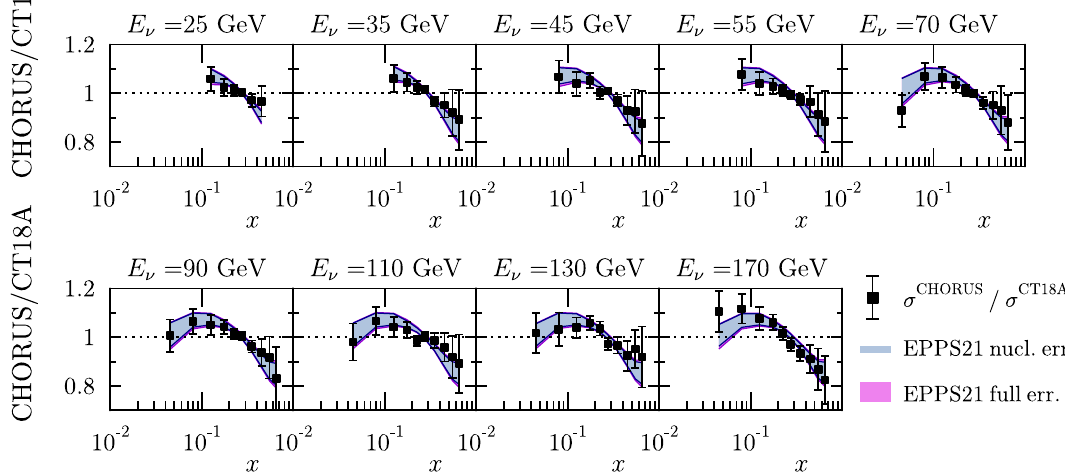
Fig. 22 The charged-current neutrino–nucleus CHORUS data [49] compared with the EPPS21 fit. Blue bands show the nuclear uncertainties, and the purple bands the total